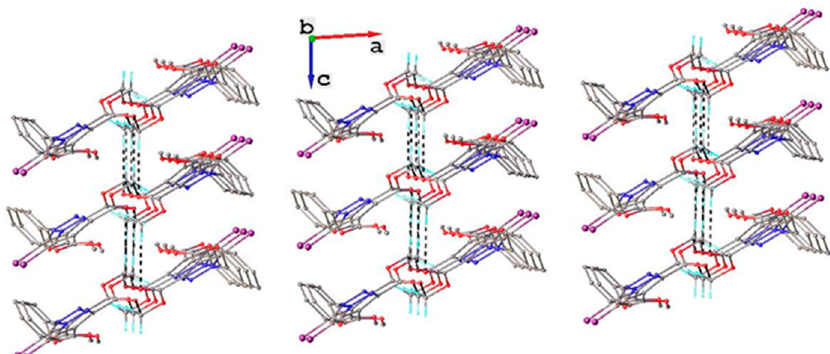
Figure 6. Crystal packing diagram viewed along the b -axis for compound 2 . Non-relevant H atoms are not shown. H-bond parameters: C13-H13A···O1 [C13-H13A 0.960 Å, H13A···O1( x , 1.5 − y , z − 0.5) 2.58 Å, C13···O1 3.528(3) Å, ∠ C13HO1 168.0°; C13-H13C···O1 [C13-H13C 0.96 Å, H13C···O1(1 − x , 0.5 + y , 0.5 − z ) 2.55 Å, C13···O1 3.465(3) Å, ∠ C13HO1 160.4°.